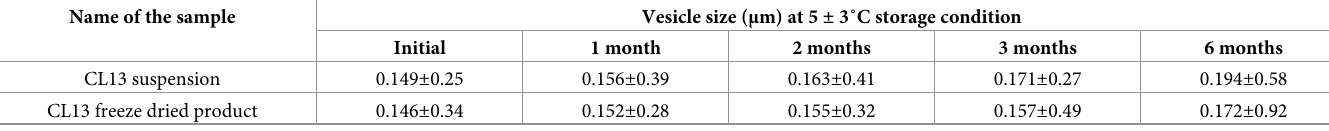
Table 4. Comparative data for changes in vesicle size of CL13 at ambient storage condition over 6 months period.